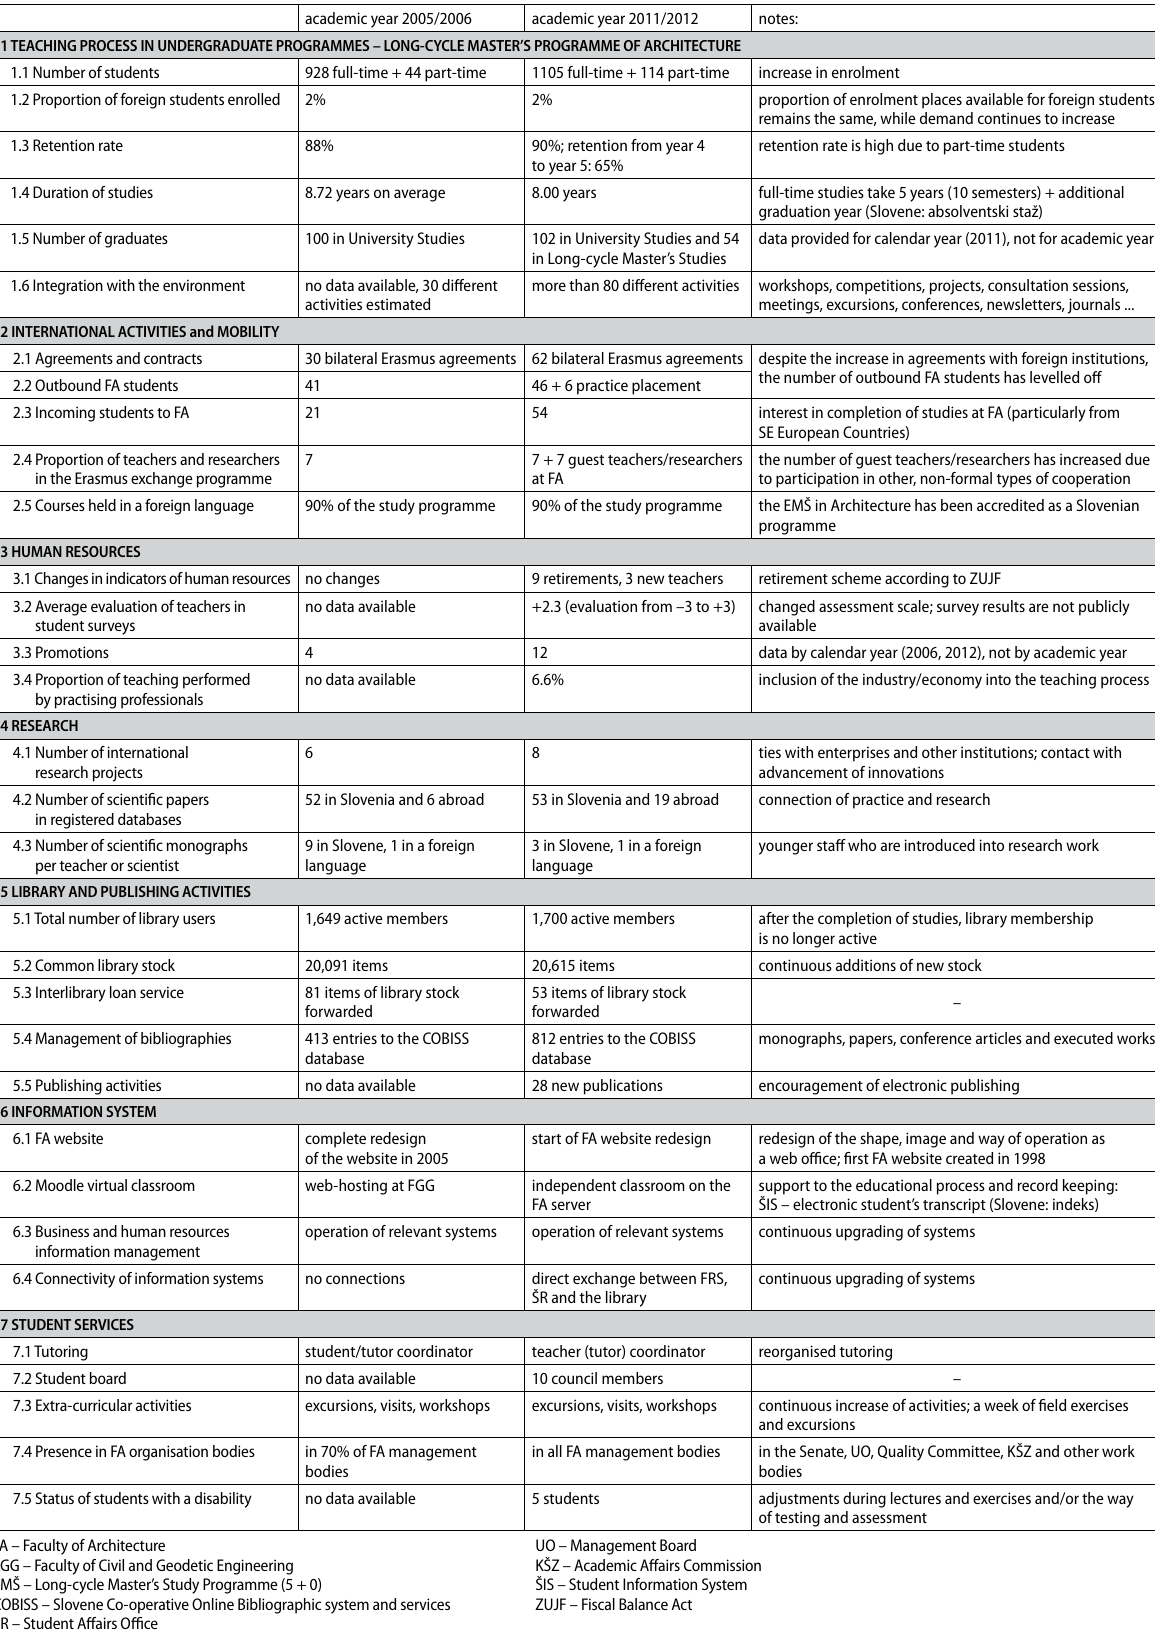
Table 1. Quality and monitoring of basic indicators at the ul fa, comparison between academic years 2005/2006 and